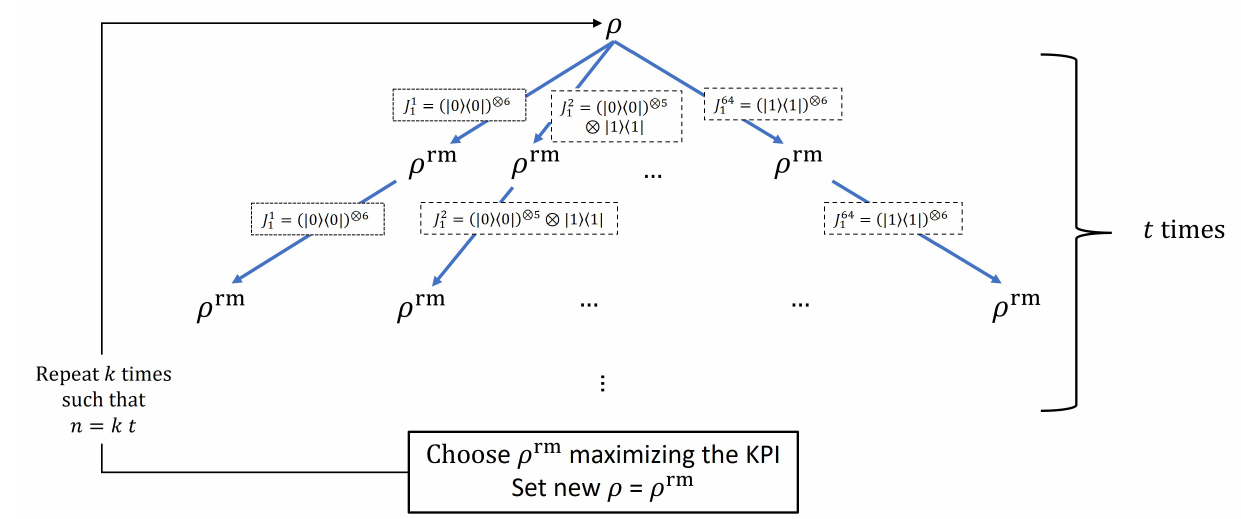
Figure 6. Algorithm for optimizing the QZD evolution. For t iterations, the evolution takes place in all the possible uninhibited subspaces with the threshold operators J i evolution block. Then the best ρ rm is chosen and set as the new starting point for the next block of t operations. Repeating the block of t operations for k times, the overall n = kt operations are completed. Parameter t determines the level of the greediness of the algorithm. Please see the text for